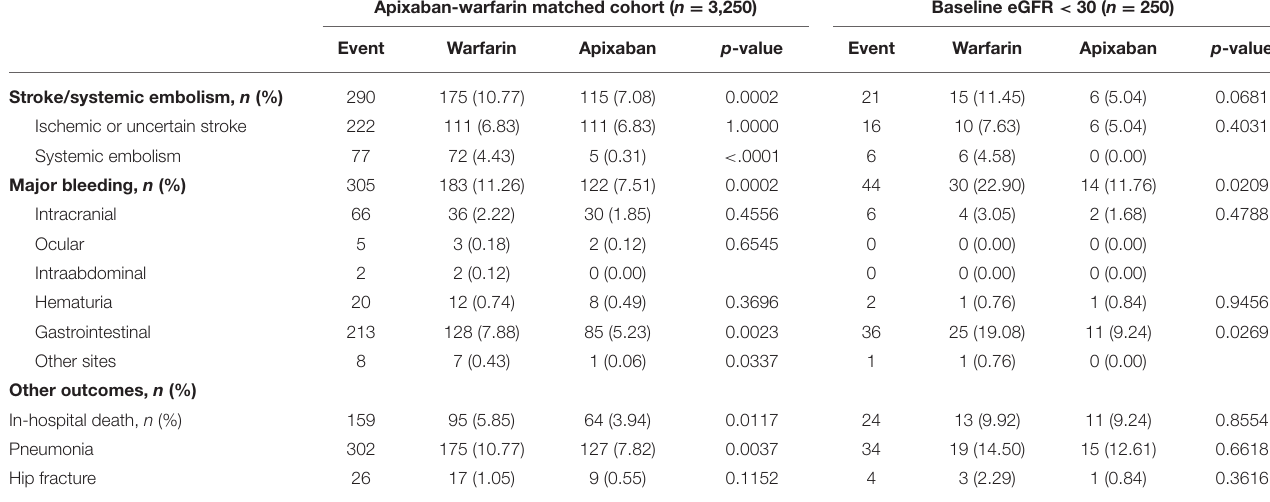
TABLE 2 | Study outcomes in the matched cohort and in the advanced CKD